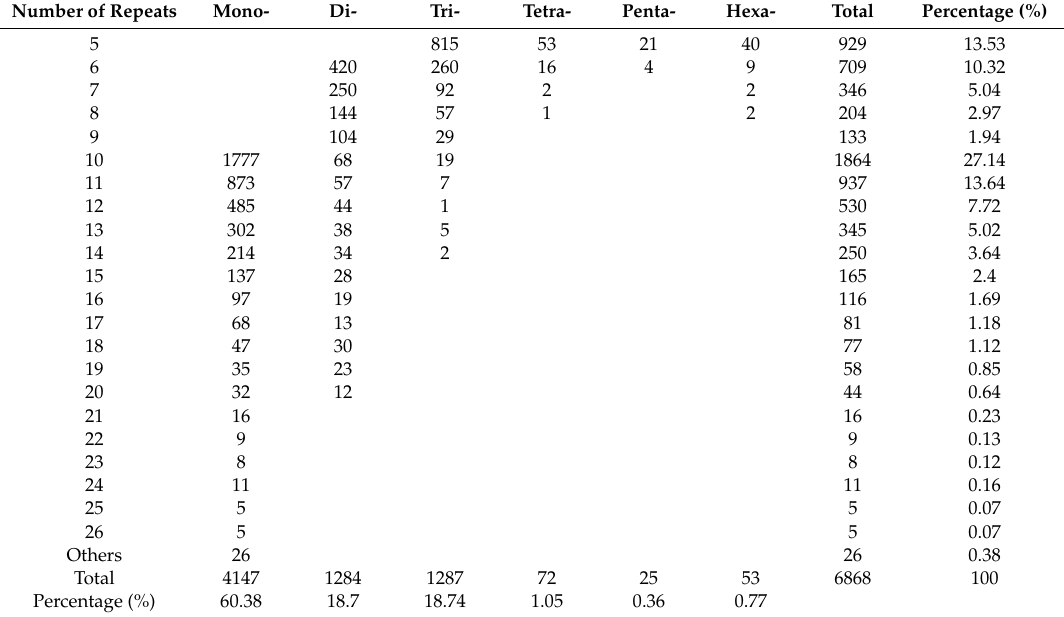
Table 2. The number of repeats in each di ff erent motif length in Pinus koraiensis .